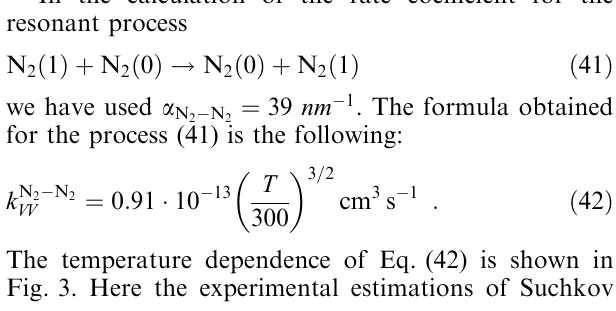
Fig. 3. Here the experimental estimations of Suchkov